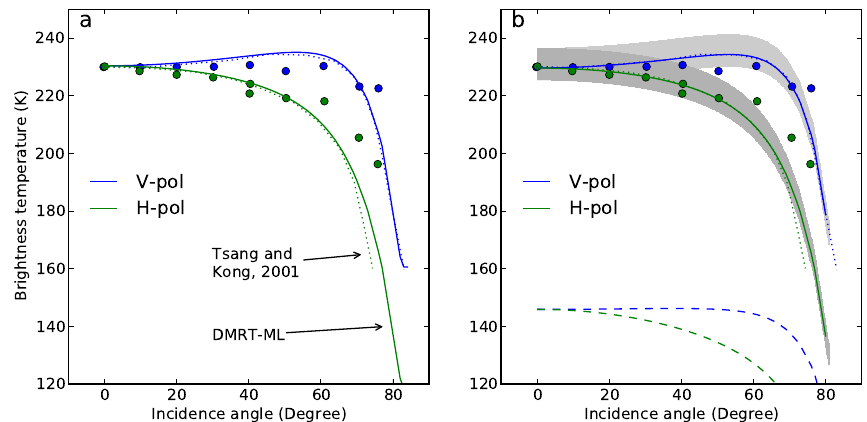
Fig. 3. Comparison of DMRT-ML simulations (solid line) at 18GHz with previous calculations (Tsang and Kong, 2001) (dotted curve) and with experimental observations (filled dots). The medium is semi-infinite, with a density of 350kgm − 3 , a temperature of 272K, a grain radius of 1.75mm and an ice dielectric constant of 3 . 2 +  0 . 016. Simulations with a more realistic dielectric constant (M¨atzler and Wegm¨uller, 1987) are shown on the right panel with the original radius of 1.75mm (dashed curve) and refitted radius of 0.83mm (solid line). The gray bars represent variations of the dielectric constant imaginary part of ± 20% around in the later